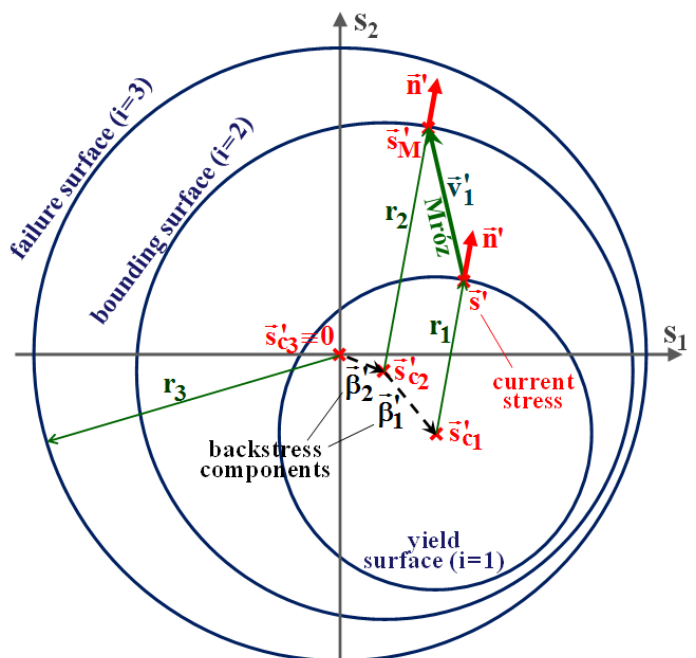
Figure 5: Yield, bounding, and failure surfaces in the s 1 -s 2 deviatoric space for the two-surface model. In summary, the two-surface model and its variations combine elements of both Mróz and NLK multi-surface models, as compared in Tab. 2. Similarly to Mróz multi-surface models, it is an “uncoupled formulation” since the generalized plastic  v  . On the other hand, similarly to NLK modulus P is not a function of the translation directions, only of the distance | | i multi-surface models, the yield and all hardening surfaces translate, the surface translation direction can (and should) use a non-linear equation, and the generalized plastic modulus P continuously varies instead of being assigned piecewise- constant values.